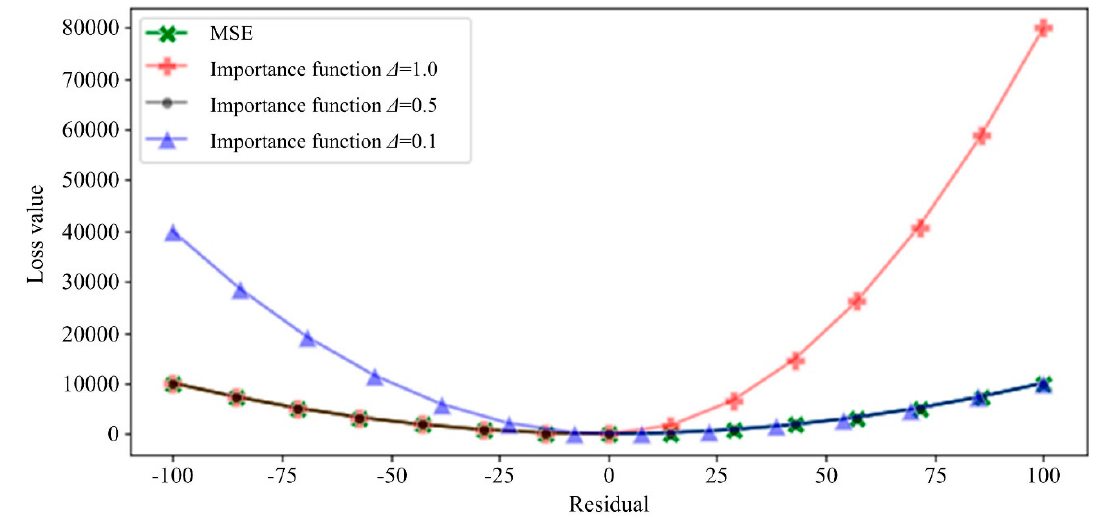
Figure 3. Comparison of importance function and MSE function of different processing state coefficients when T sp =0.5.